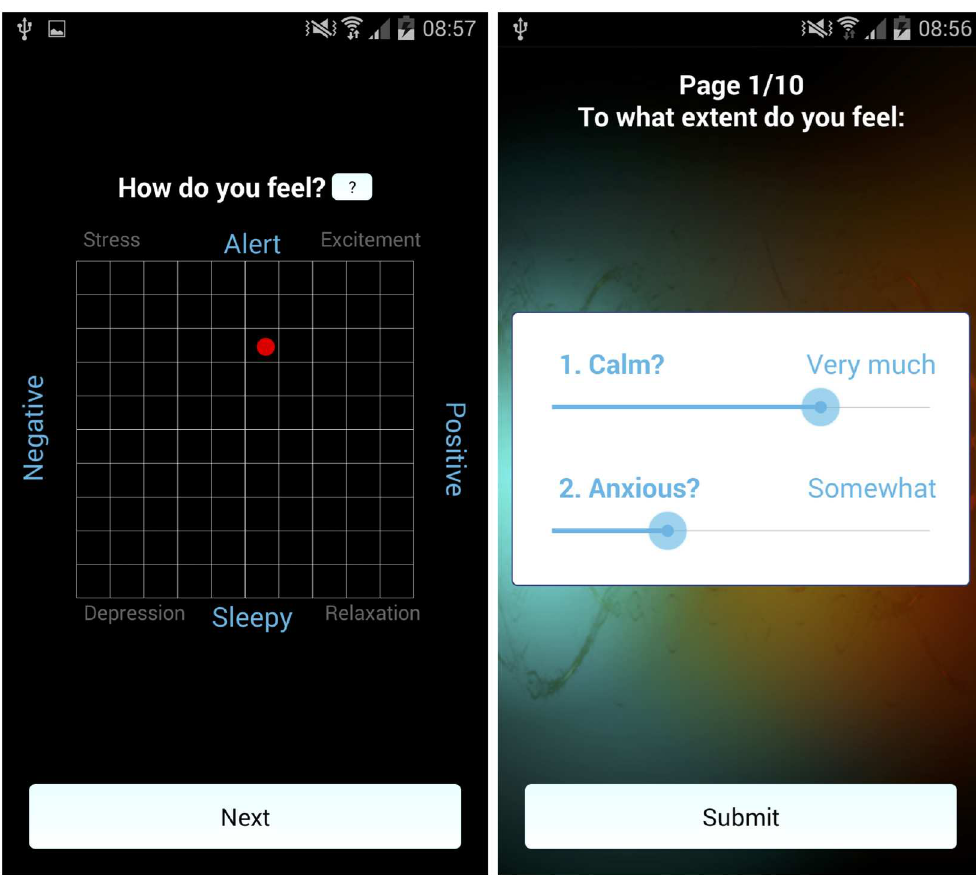
Fig 1. Self-Reported Mood in the app. From left to right: (a) Measuring happinessin the app using the affect grid: users select a point on a grid that quantifies valence(horizontally)and arousal(vertically). (b) Measuring happiness with PA/NA